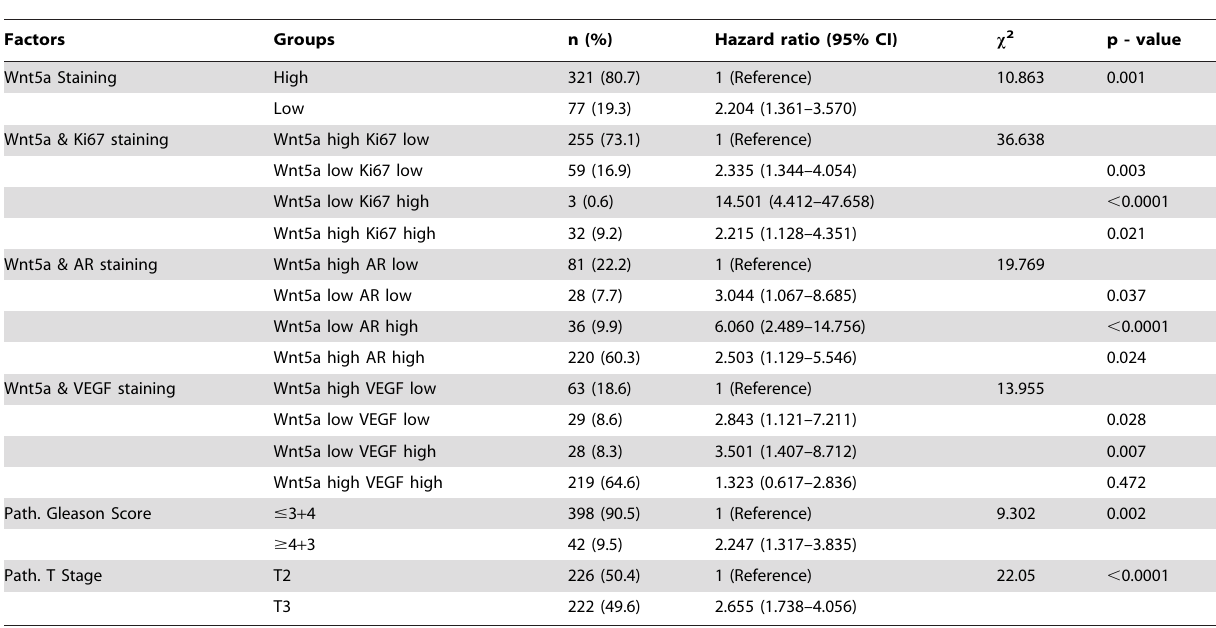
Table 4. Multivariate analysis of factors influencing biochemical relapse-free survival.